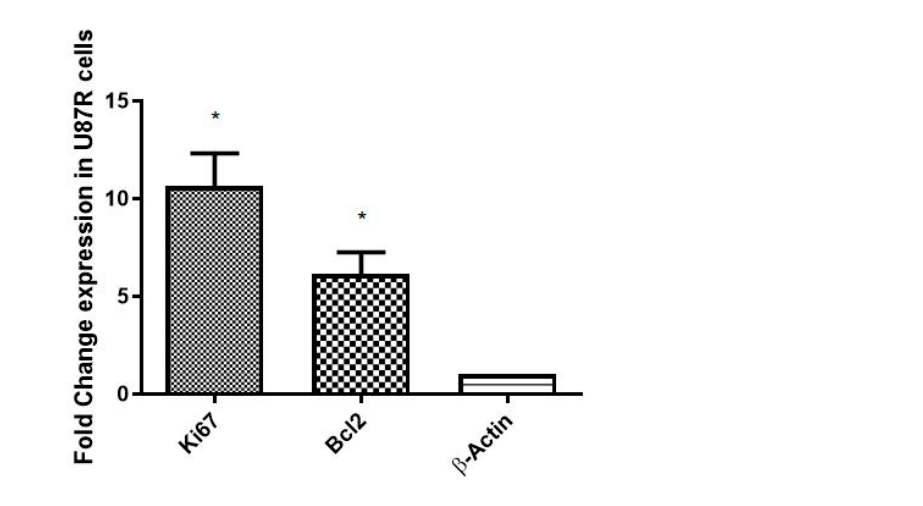
Figure 11. Fold change in expression of Ki67 (proliferation marker) and bcl2 (anti-apoptotic marker) in U87-S and U87-R. Each bar shows mean ± SD values for each gene; experiments were conducted in triplicate. The results are normalized to β -actin, a housekeeping gene and are expressed as a change from their respective controls. The level of significance is * p ≤ 0.05.